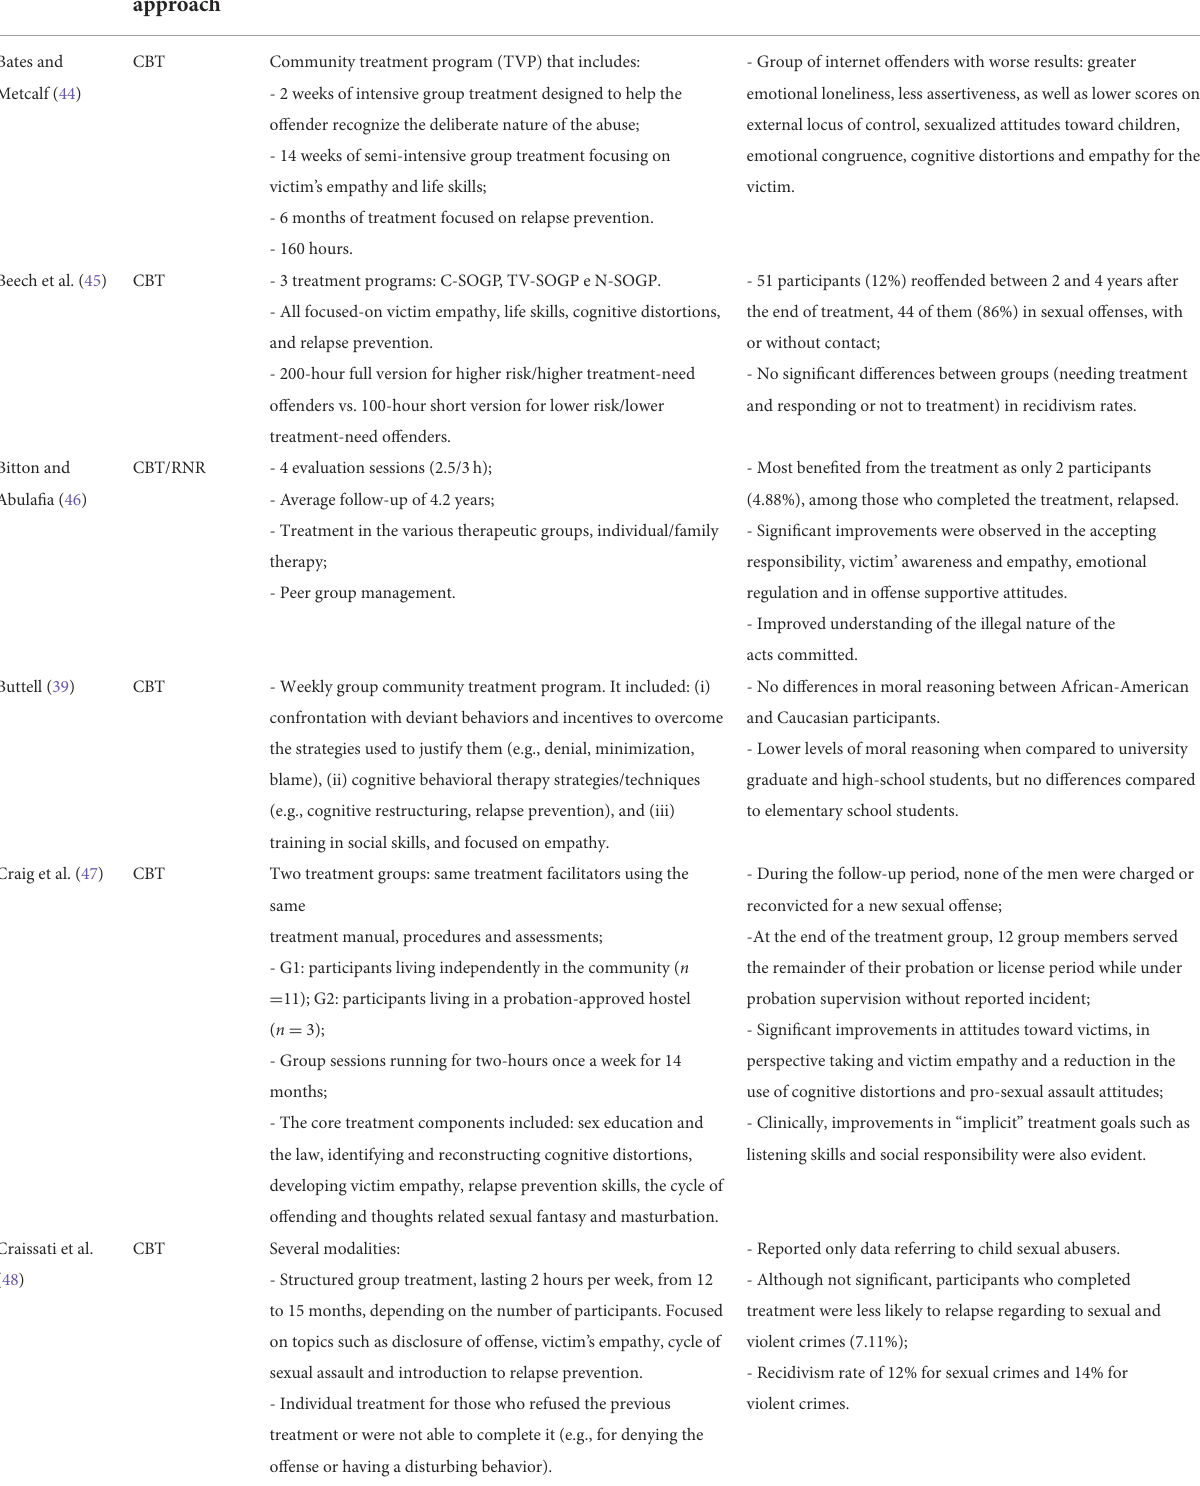
TABLE 3 Intervention characteristics and